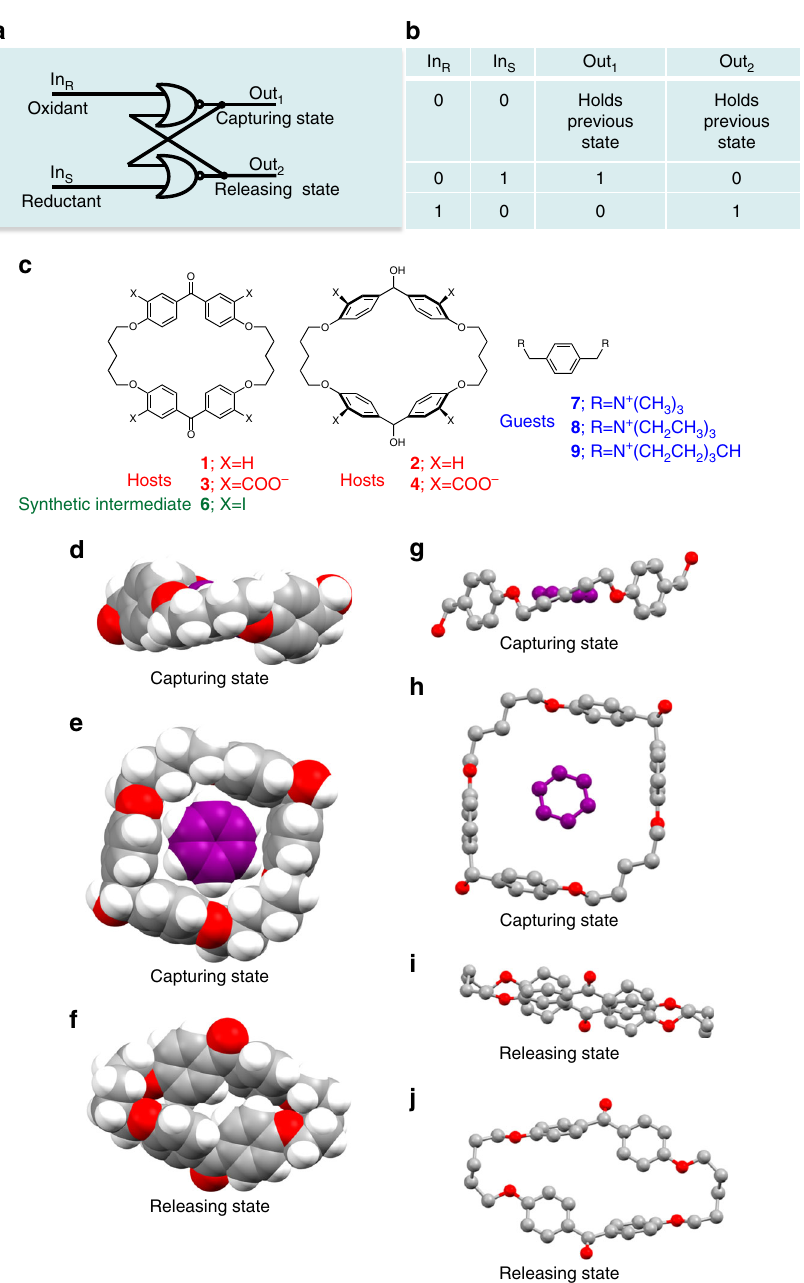
Fig. 1 Memory, chemical compounds and X-ray crystallography. a Physical electronic representation of a computer memory which is conceptually related to the redox-induced reversible guest capture/release by 1 / 2 in the solid state. b Truth table for redox-induced reversible guest capture/release by 1 / 2 . c Molecular structures 1 – 4 & 6 – 9 (no stereochemistry is implied). The structure numbers and group identities of hosts, guests and synthetic intermediate are shown in the arbitrary colours of red, blue and green, respectively. d – j X-ray crystal structures of 2 ( d , e , g , h ) and 1 ( f , i , j ) after separate crystallization from benzene. Ball-and-stick representation in elevation view ( g , i ), space- fi ll representation (with calculated hydrogen positions included) in plan view ( e , f ) and ball-and-stick representation in plan view ( h , j ), are shown in each case, respectively. Case d is a space- fi ll representation (with calculated hydrogen positions included) of 2 shown in elevation view to emphasize the ‘ wall ’ aspect of the